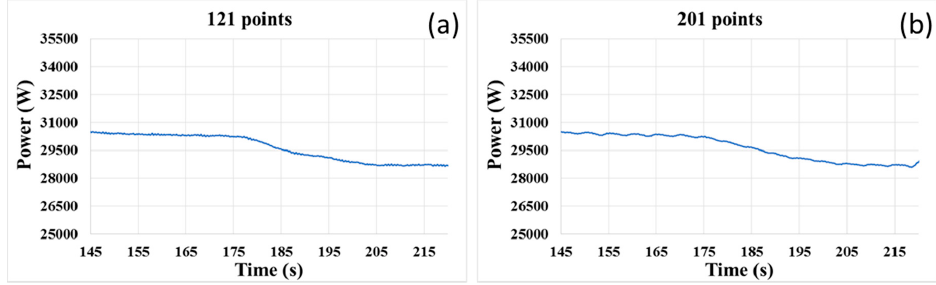
Figure 7. Smoothing results with different span of the moving window: ( a ) 121 points; ( b ) 201 points.